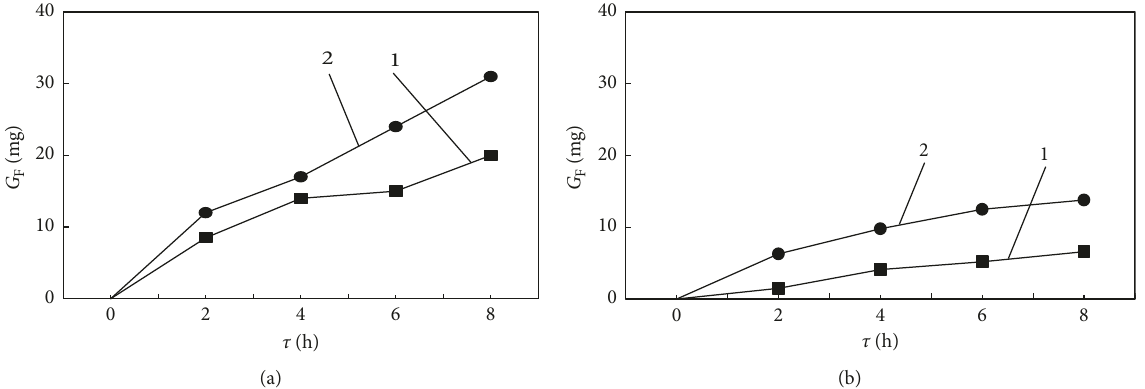
Figure 6: Wearing kinetics for friction pair 40Kh steel-40Kh steel after VCH and hardening ((a) ring; (b) insert) under a load of 2MPa in the oil environment: (1) VCH; (2) hardening with low tempering (200 °